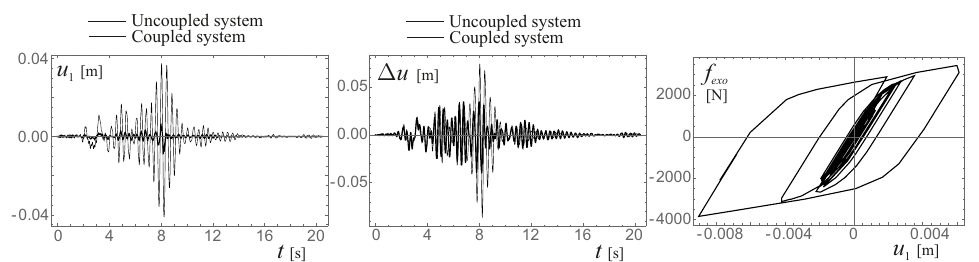
Figure 11. Time-histories and hysteretic cycle of the system with characteristics labelled with A in Figure 10 ( ψ = 0.1, γ = 0.1).